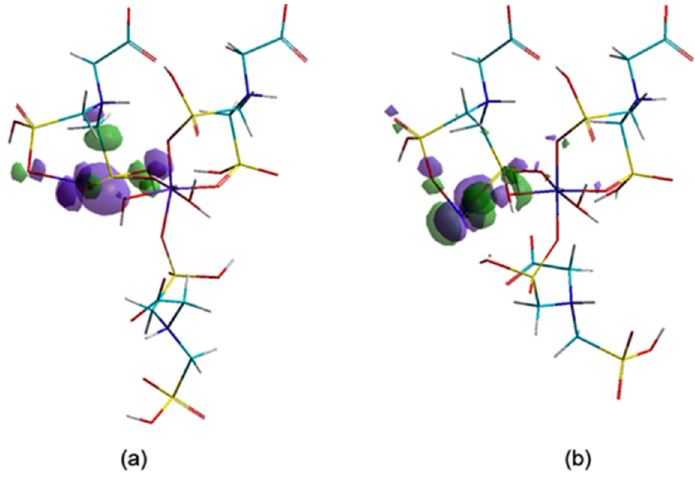
Figure 10. The highest occupied molecular orbital (HOMO) components ( a ) Ni–Gly; ( b ) Co–Gly.